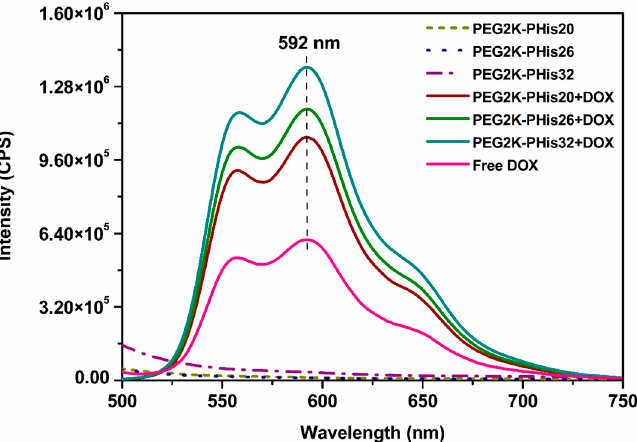
Figure 6. Overlapping the emission spectra of the unloaded micelles and DOX-loaded micelles of the free DOX with the highlighting of the emission peak given by DOX at 592 nm.